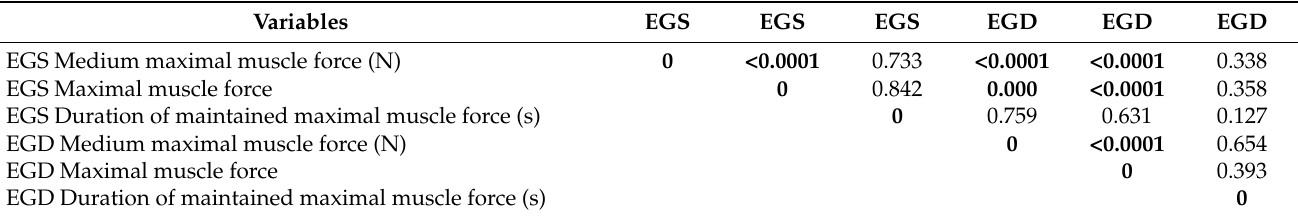
Table 18. p -values for Pearson correlation between muscle parameters of left and right knee